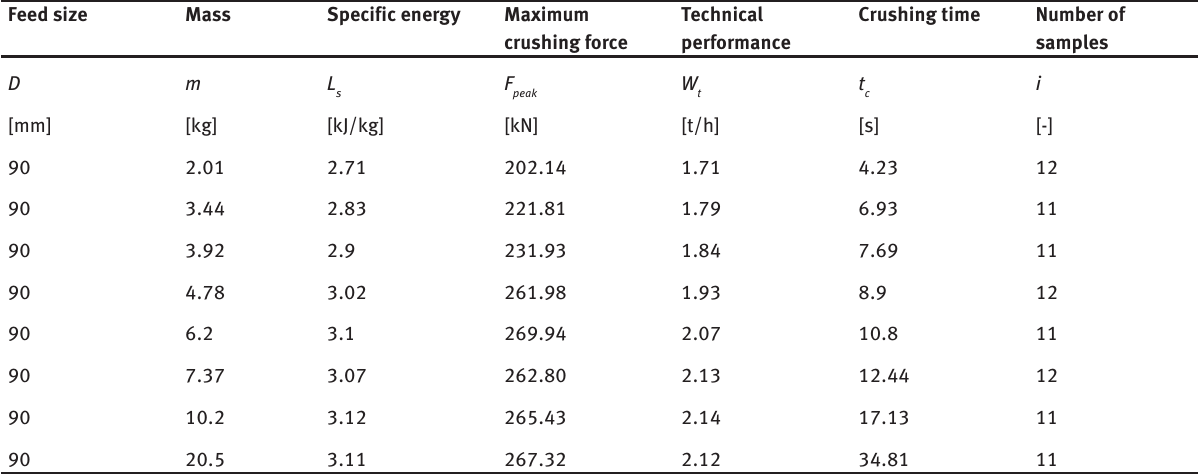
Table 1: Changes in crushing parameter values as a function of feed mass. Maximum crushing force, specific energy, technical performance and crushing time. Crushing of sandstone “Mucharz” between the flat plates Feed